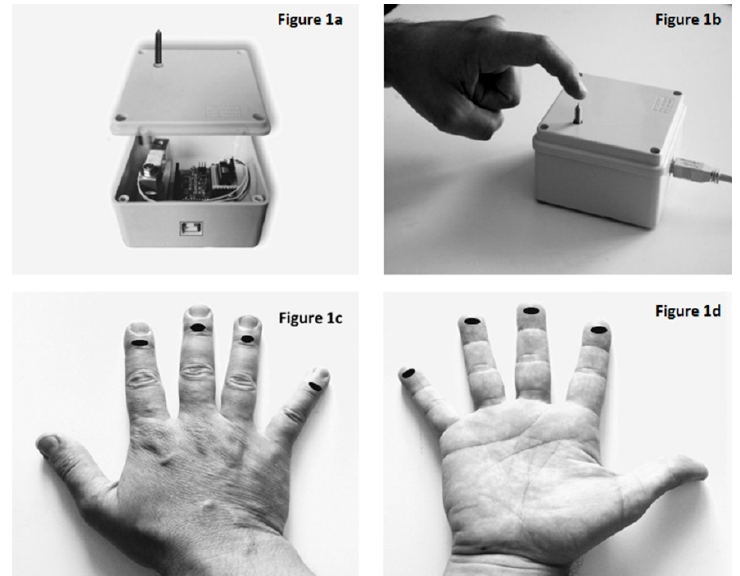
Figure 1. The autoalgometer consists of a cylindrical metal probe 1 mm in diameter with a round tip, fixed in a vertical position to a cell load. ( a ) On the back side, there is a USB port that connects the device to the PC. ( b ) Each subject pushes down on the tip of the probe, increasing pressure (slow or fast) until a minimum or maximum tolerable pain sensation is felt. The test was performed for each hand landmark: eight points on the dorsal surface ( c ) and the tip ( d ) of the third phalanx of the second, third, fourth, and fifth fingers were recorded.